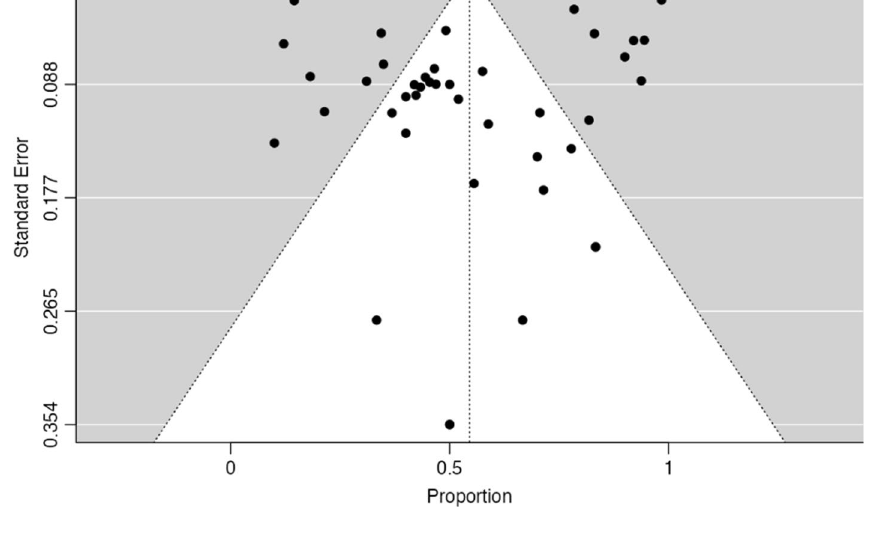
Fig. 6 Forest-plot describing the proportion of EBV positiv- ity in